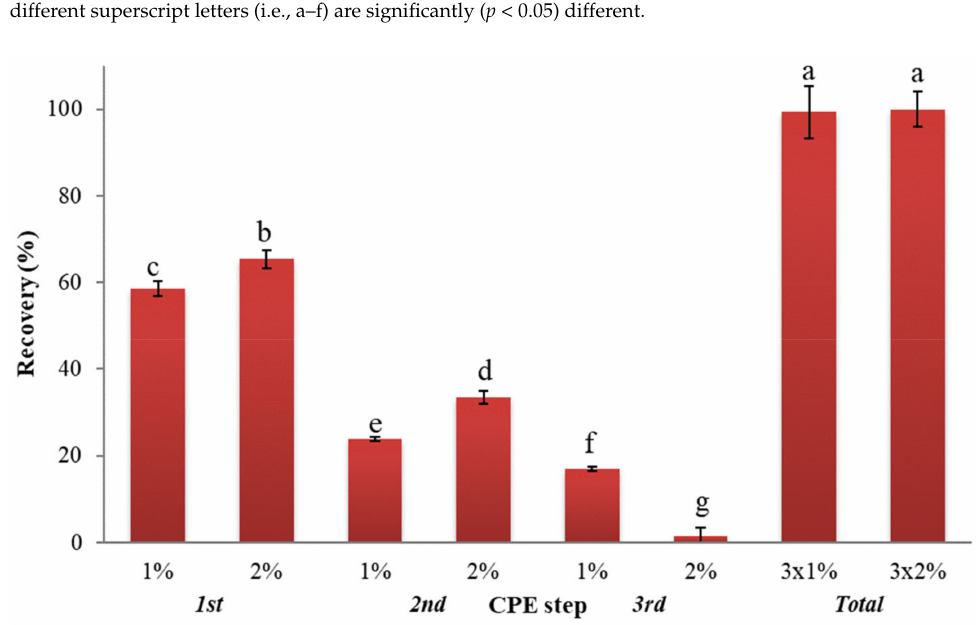
Figure 4. % Carotenoid recovery with lecithin on LTW; Standard deviation is presented with error bars; Different letters (i.e., a–g) denote samples that differ significantly (statistical difference for p <